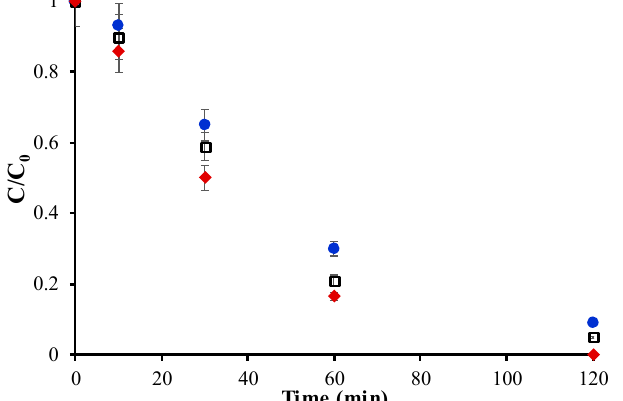
Figure 9. Time course of SMZ photodegradation with irradiation time corresponding to three consecutive SMZ photodegradation cycles using the same 5%rGO/Bi sample. [SMZ] 0 = 15 mg/L and m catalyst = 0.03 g. Cycles: ( (cid:117) ) first, ( (cid:3) ) second, and ( • ) third.